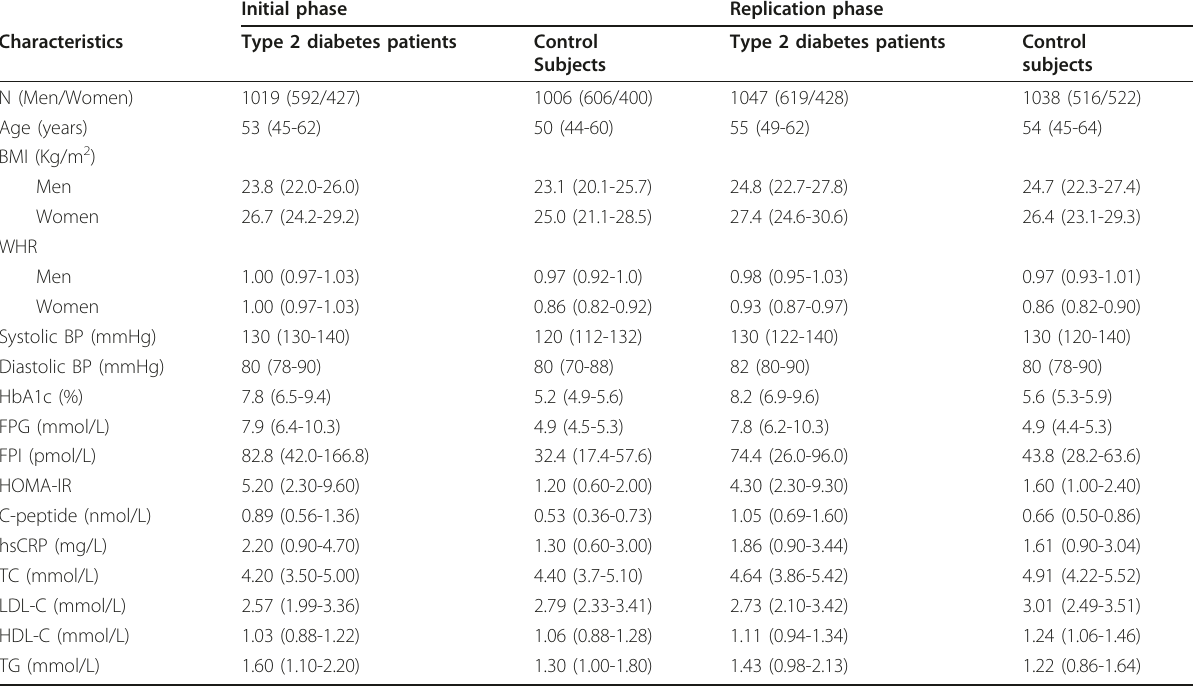
Table 1 Anthropometric and clinical characteristics of the study